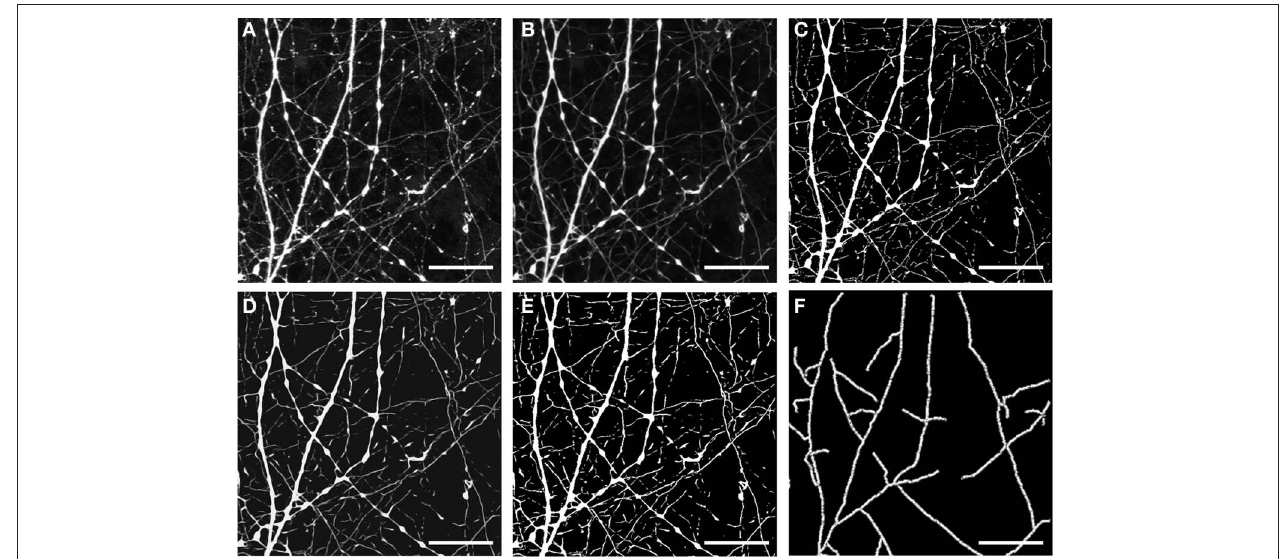
FIGURE 3 | Representative example of outcomeof the different steps in dendrite image processing.(A) Raw data—image stack corresponding to morphological structure (in this case resulting from eGFP expression). (B) The same image stack following filtering; (C) filtering and segmentation;